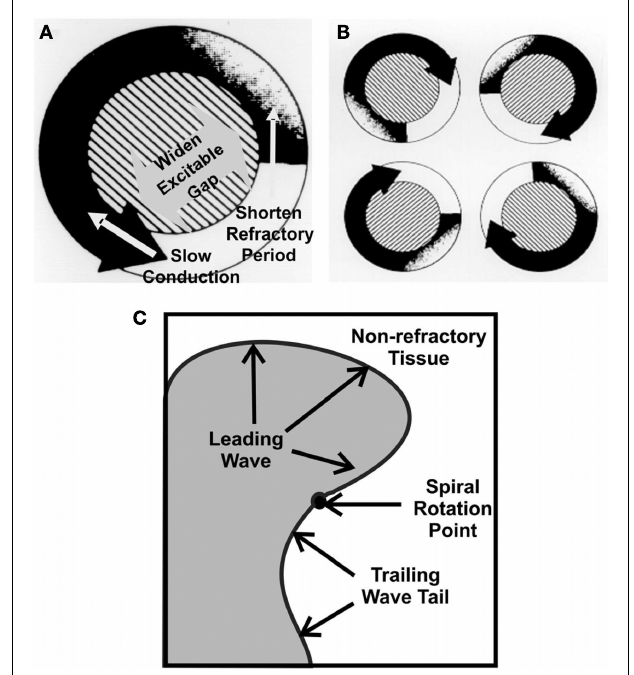
FIGURE 1 |The leading circle, “wave length,” of re-entry in atrial fibrillation (AF). The size of a functional re-entry circuit [ (A) , right], depends on the wavelength (WL) which is a product of conduction velocity (CV) and refractory period (RP;WL = CV × RP). Short wavelengths allow multiple circuits [ (B) , left], favoring AF.The wave rotating around a fixed point, rotor [ (C) , lower; Jalife, 2003]. Factors such which slow conduction enhance the potential for multiple smaller waves. Enhanced cholinergics decrease conduction velocity and/or reduce effective refractoriness. Modified connexins also slow conduction. Either, or a combination of both could promote the initiation and sustaining of AF.